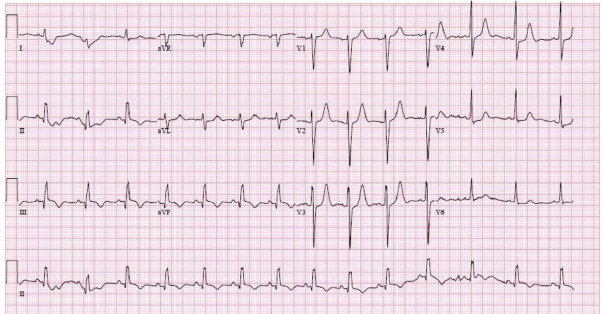
Figure 1: EKG showing normal sinus rhythm, Q waves in the inferior wall leads concerning old myocardial infarction.